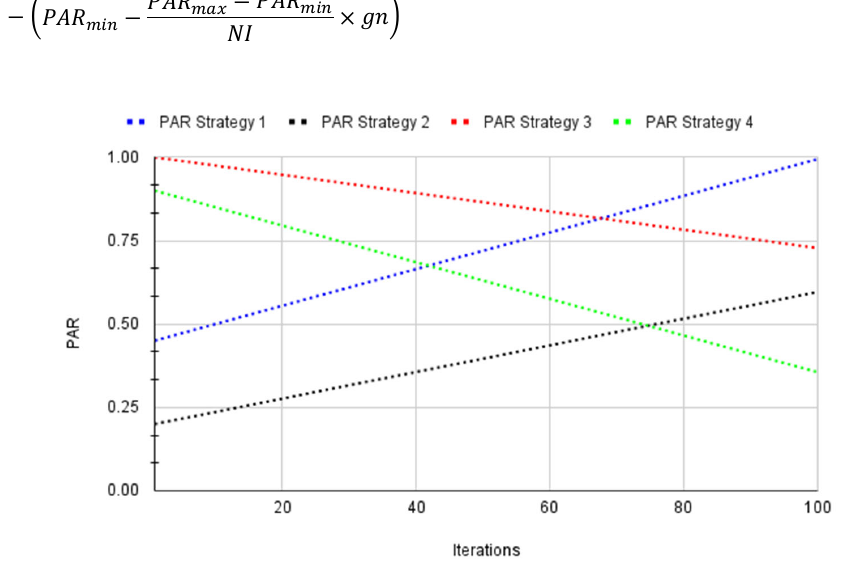
Fig. 2. Adaptive PAR strategies- change in PAR